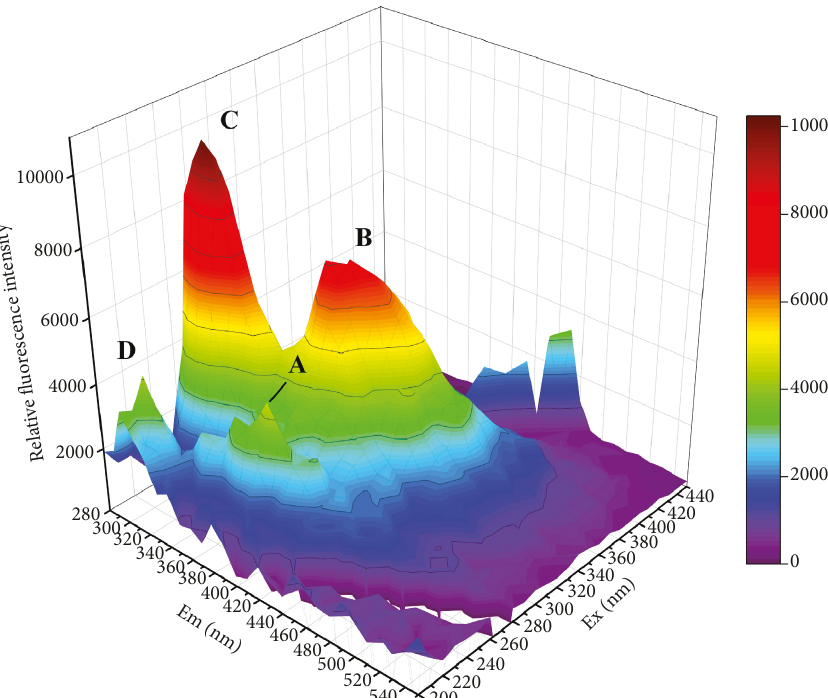
Figure 8: 3D-EEM of thermal desorption raw